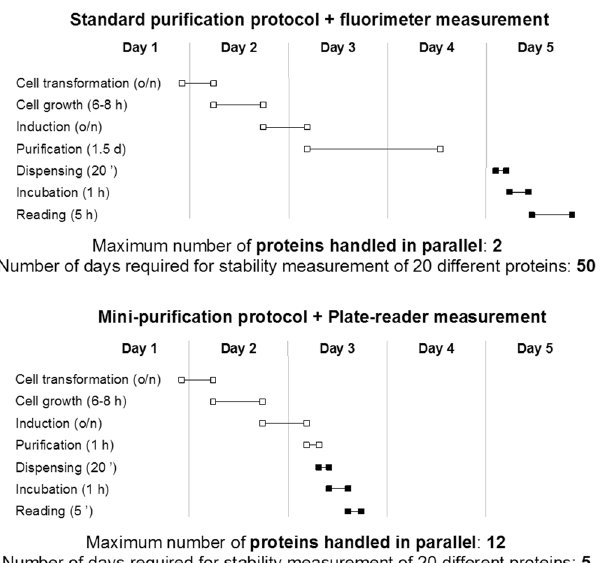
Figure 1. Comparison of timescales (based on an 8-hour working day) for protein production and stability measurement using our miniaturised method versus the standard method. The power of our method lies in its ability to produce data on multiple proteins in parallel, leading to an order of magnitude reduction in overall experimental time (for 20 proteins, 5 days versus 50 days). Moreover, the data produced by the miniaturised method are potentially of higher quality that those produced by the standard method, as biological replicates can be performed in parallel (i.e. with little additional experimental time) with our